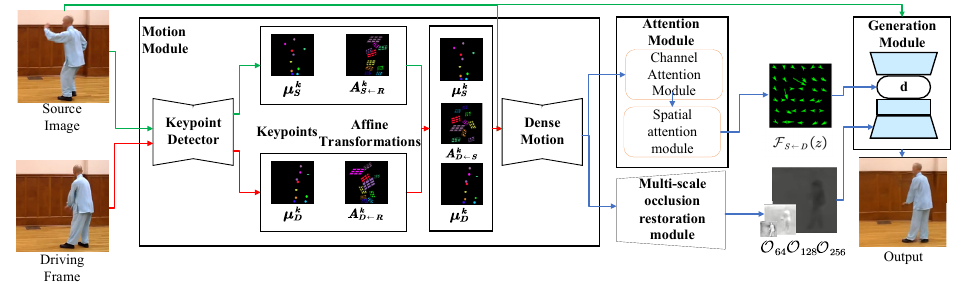
Figure 4. The framework of our method.